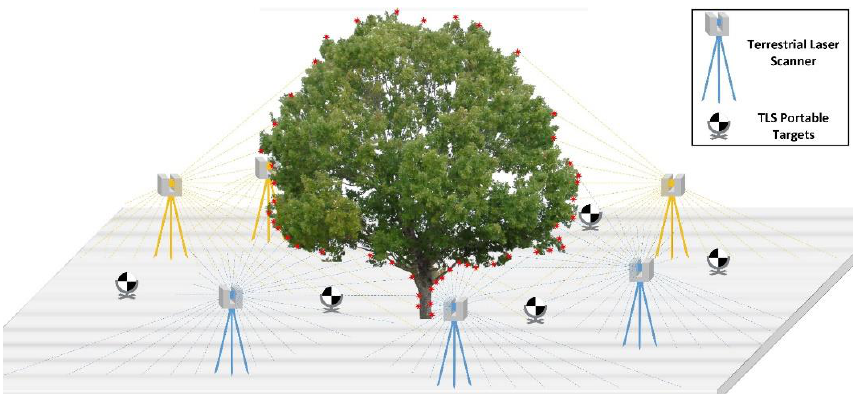
Figure 2. Location of scan stations